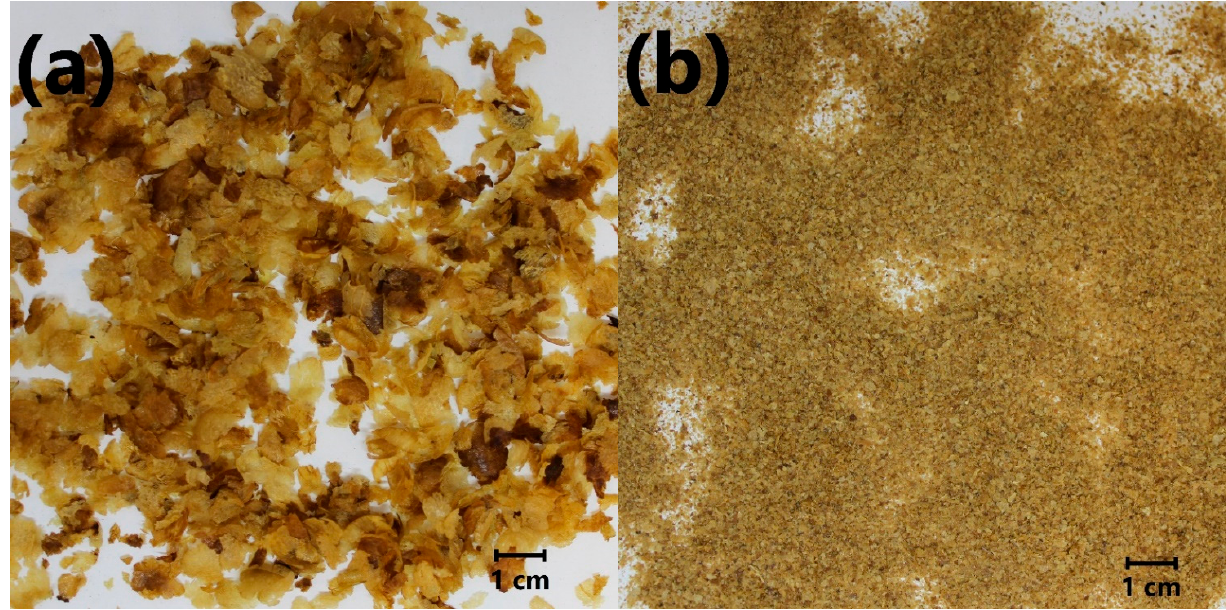
Figure 1. The appearance of the applied coffee silverskin ( a ) before and ( b ) after